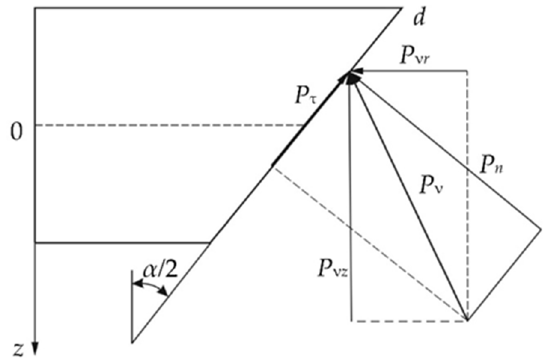
Figure 3. Components of the vector of support